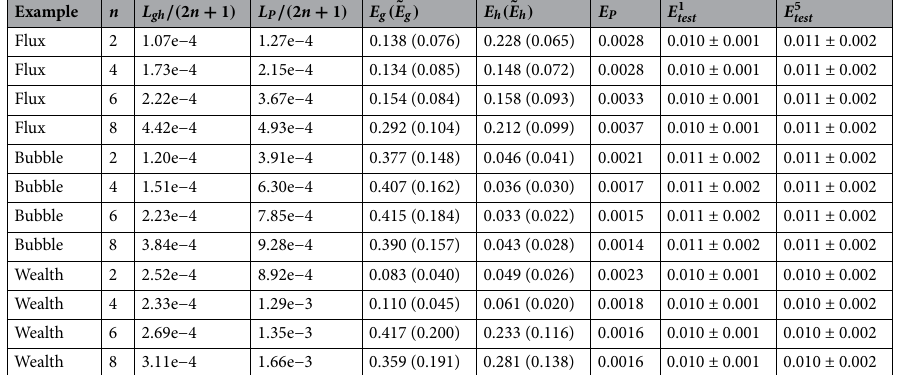
Table 1. Summary of the evaluation metric values of the simulated data from three FPE examples. The number of the training distribution sequences is fixed as 100. n is the output time point range used in Eqs. (4) and